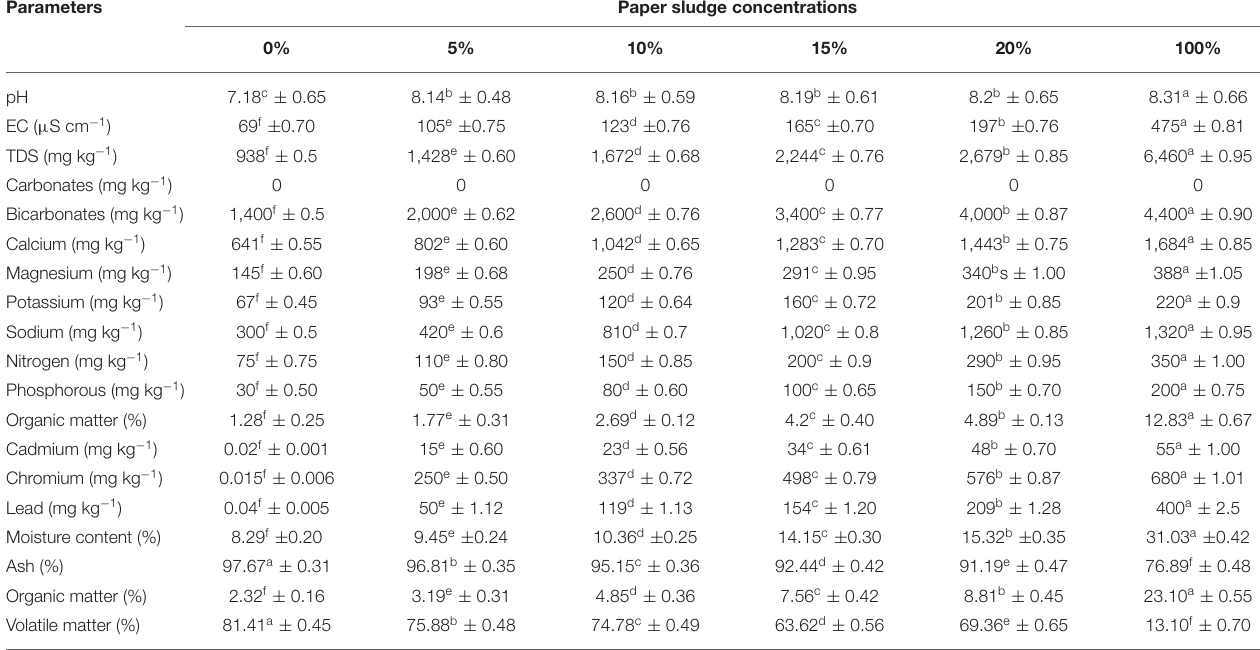
TABLE 1 | Physicochemical parameters of different concentrations of paper sludge-amended soil before transplantation of Brassica napus plants. Parameters